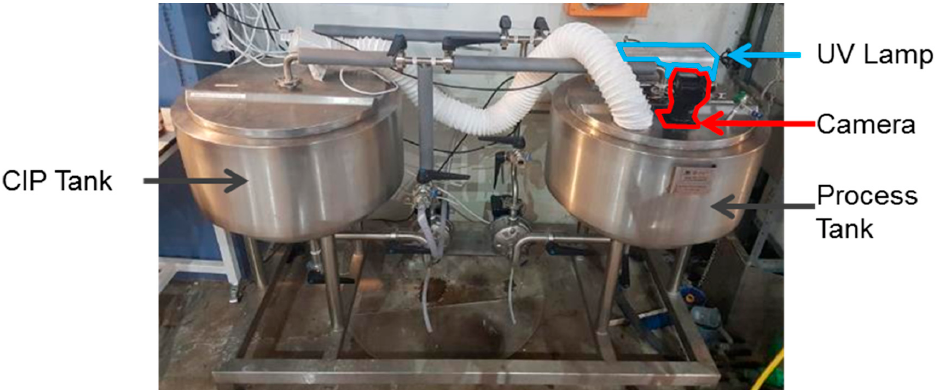
Figure 3. Experimental rig.